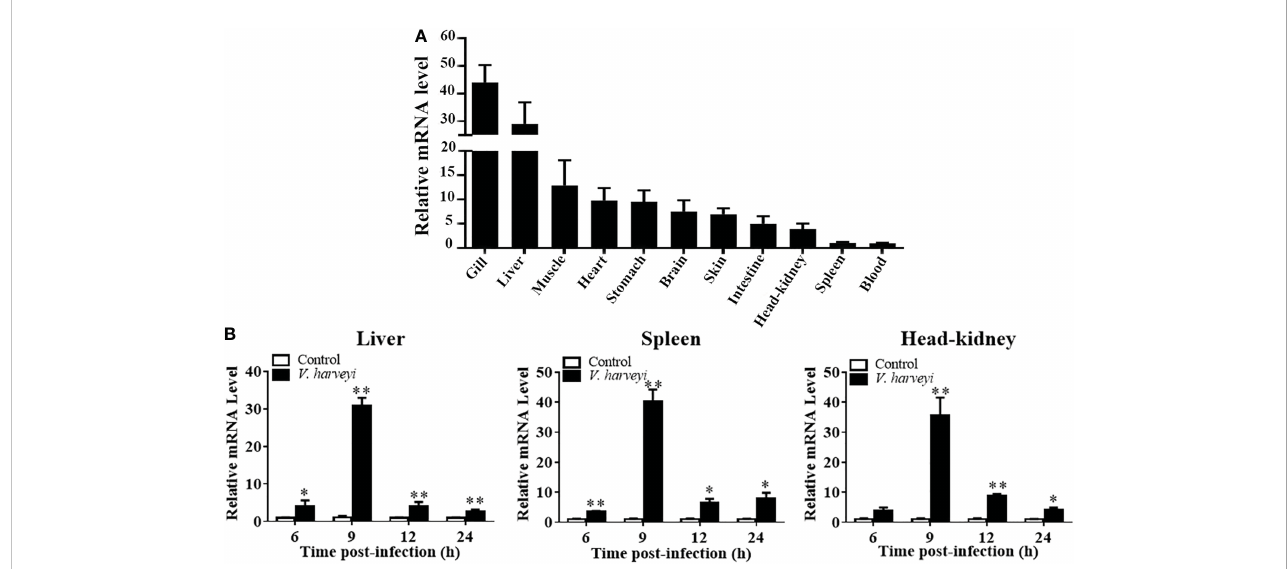
FIGURE 2 Expression pro fi les of TroIRF3 in normal tissues and when challenged with V. harveyi . (A) TroIRF3 expression levels in different tissues. (B) Expression of TroIRF3 in the liver, spleen, and head-kidney in response to the V. harveyi challenge. At every time point, control fi sh were set to have an average expression level of 1. Error bars display means ± SD (N = 3). N, indicates parallel experiments. * P < 0.05, ** P < 0.01.